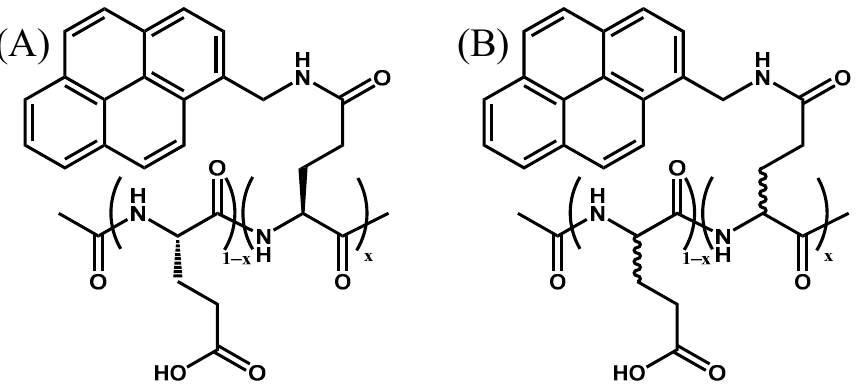
Figure 1. Chemical structure of ( A ) Py( x )-P L GA ( x = 2.9, 4.4, 4.9, 6.9, 9.0, and 14.3 mol%) and ( B ) Py( x )-P DL GA ( x = 6.0, 8.0, 10.4, 11.3, and 12.3 mol%) samples used in this study.